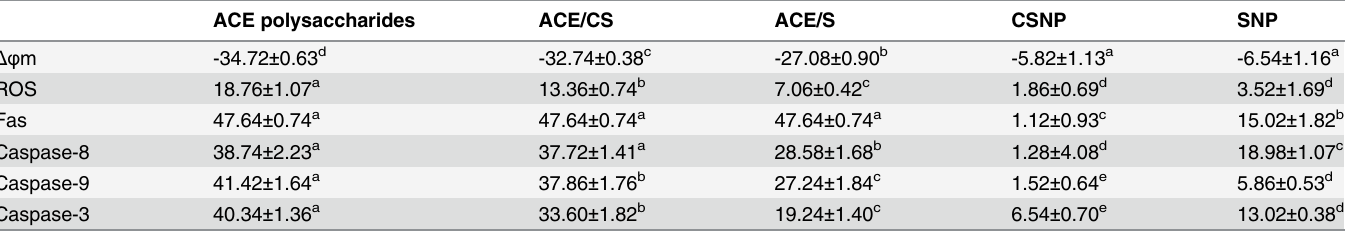
Table 2 and S3 Fig. After 48 h of incubation, the ROS formation increased to 18.76% in the CS and ACE/S treatments, respectively. The effects of SNP or CSNP on ROS generation are Table 2. Effects of ACE polysaccharides and resulting nanoparticles on mitochondrial transmembrane potential, ROS, Fas and caspase activities in Hep G2 cells after 48 h